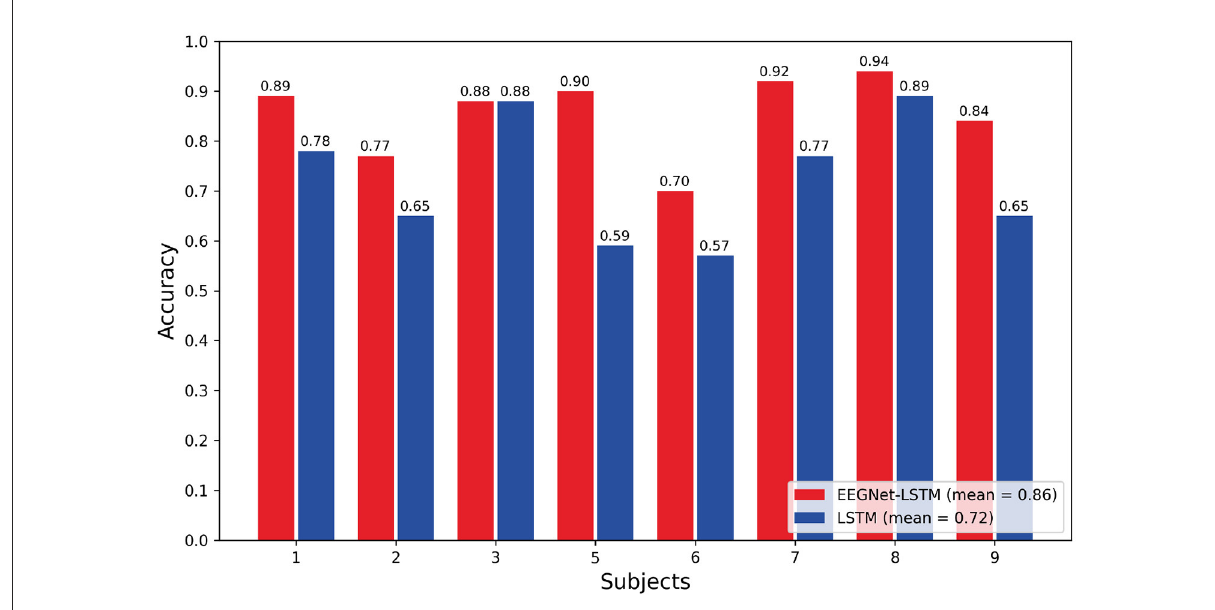
FIGURE4 Comparison of the accuracy obtained through the